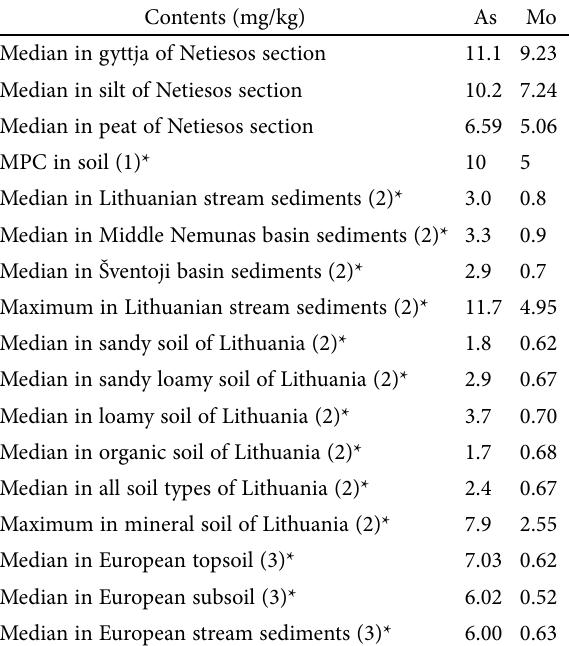
Table 2. Arsenic and molybdenum contents (mg/kg)